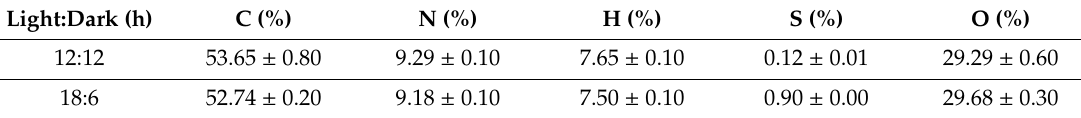
Table 2. E ff ect of the photoperiod on the elemental composition of the biomass. Light:Dark